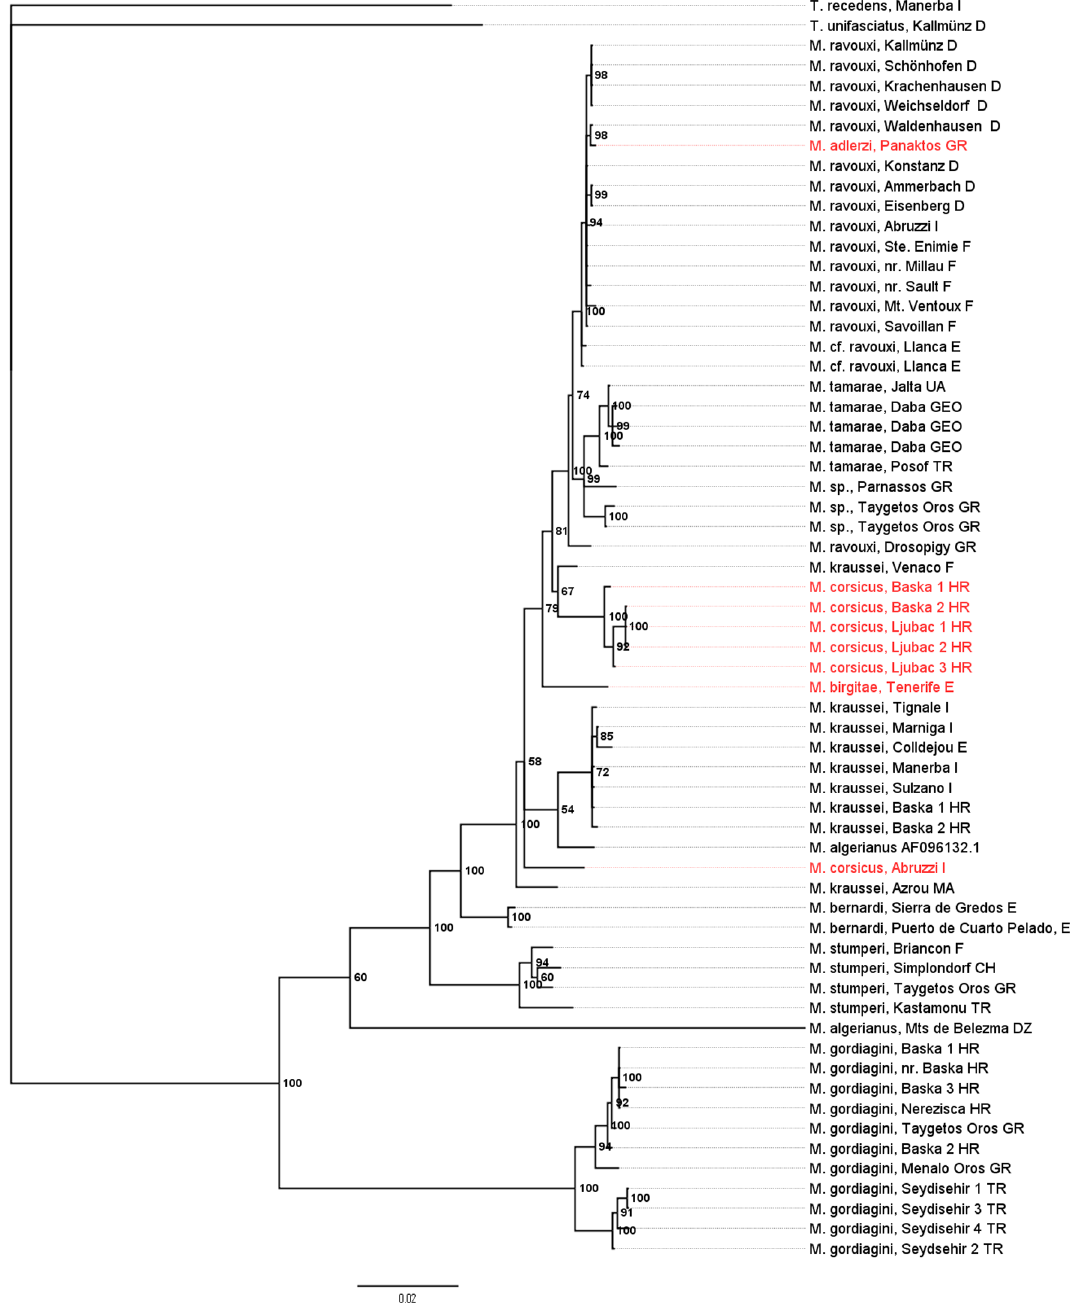
Fig 1. Bayesian tree of the socially parasitic ant genus Myrmoxenus inferred from sequences of the nuclear gene wingless and the mitochondrial gene CO I / CO II. Bayesian posterior probabilities (as percentages) are given at the nodes. Workerless species are given in red.